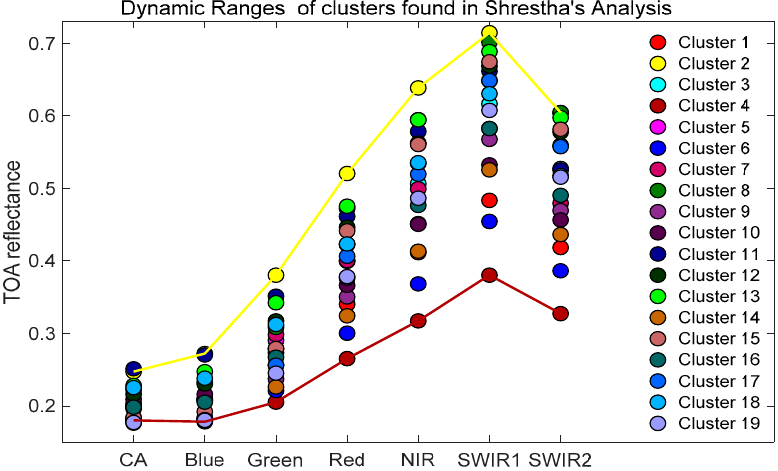
Figure 12. Dynamic ranges of clusters found by Shrestha’s analysis.